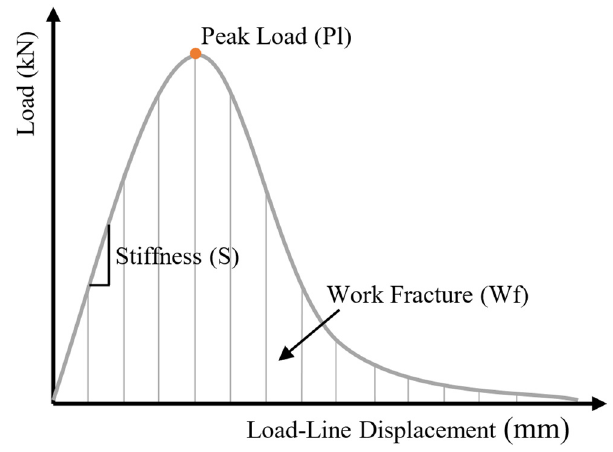
Figure 7. Theoretical load–load-line displacement diagram.